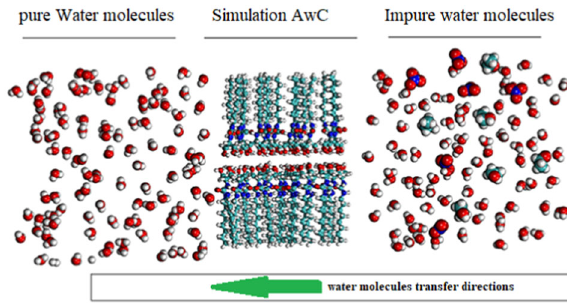
Fig. 2 A sample of the initial simulation box before each simulation